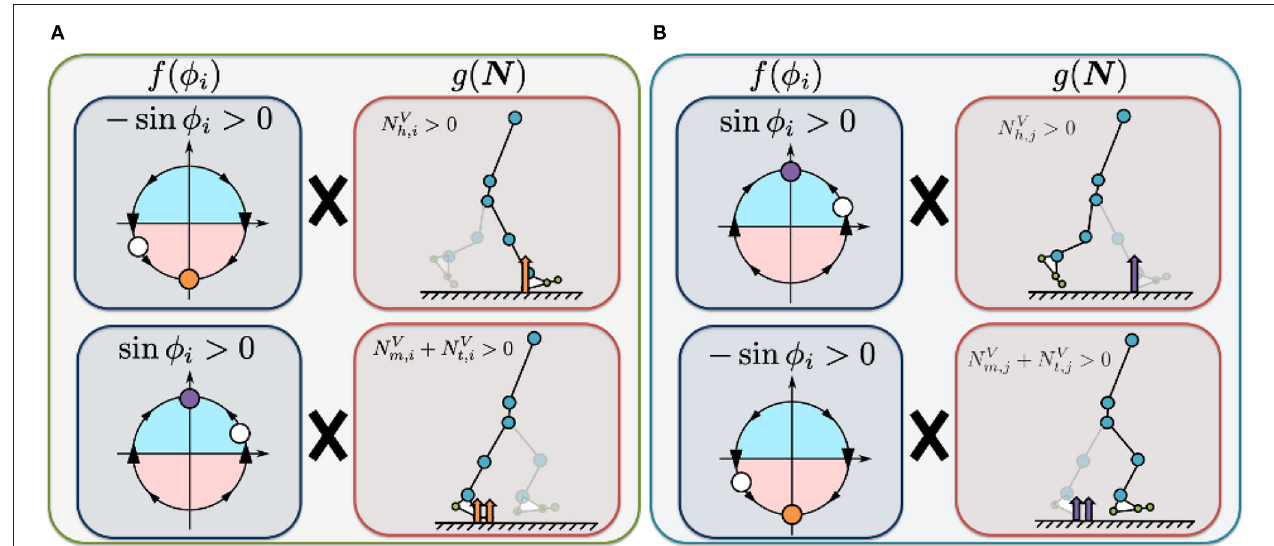
FIGURE 3 | Illustrated definition of the Tegotae function for the hip controller. For rhythmic movements, we incorporated phase oscillators as a component of the CPG-based model to generate the target angle for the hip actuators (Equation 8). (A) Tegotae function for corresponding-leg sensory information. The value of N V h , i ( − sin φ i ) is positive when the heel sensor on the corresponding leg detects a large vertical GRF ( N V h , i > 0) with the oscillator in the stance phase ( π ≤ φ i < 2 π ). In contrast, the value of ( N V m , i + N V t , i ) (sin φ i ) is positive when the metatarsal and toe sensors on the corresponding leg detect a large vertical GRF ( N V m , i + N V t , i > 0) with oscillator in the swing phase (0 ≤ φ i < π ). (B) Tegotae function for opposite-leg sensory information. The value of N V h , j (sin φ i ) is positive when the heel sensor on the opposite leg detects a large vertical GRF ( N V h , j > 0), with the oscillator in the swing phase (0 ≤ φ i < π ). In contrast, the value of ( N V m , j + N V t , j ) ( − sin φ i ) is positive when the metatarsal and toe sensors on the opposite leg detect a large vertical GRF ( N V m , j + N V t , j > 0) with the oscillator in the stance phase ( π ≤ φ i < 2 π ). The white circles represent the corresponding oscillator phase φ i . The orange and purple circles represent stable equilibrium points of Tegotae-based feedback, e.g., ∂ (sin φ i ) = cos φ i = 0 for the top of (A) (the first term in Equation ∂φ i